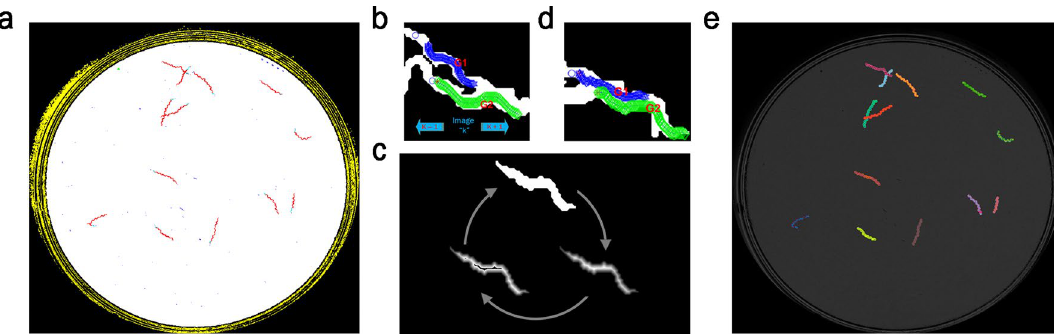
Figure 2. Image processing pipeline. ( a ) Image sequence segmentation result (background in black, region of interest in white, worm tracks in red, noise in blue). ( b ) Worms before aggregation. ( c ) Proposed skeleton technique to obtain separate skeletons. ( d ) Optimisation results (predicted poses). ( e ) C. elegans tracking